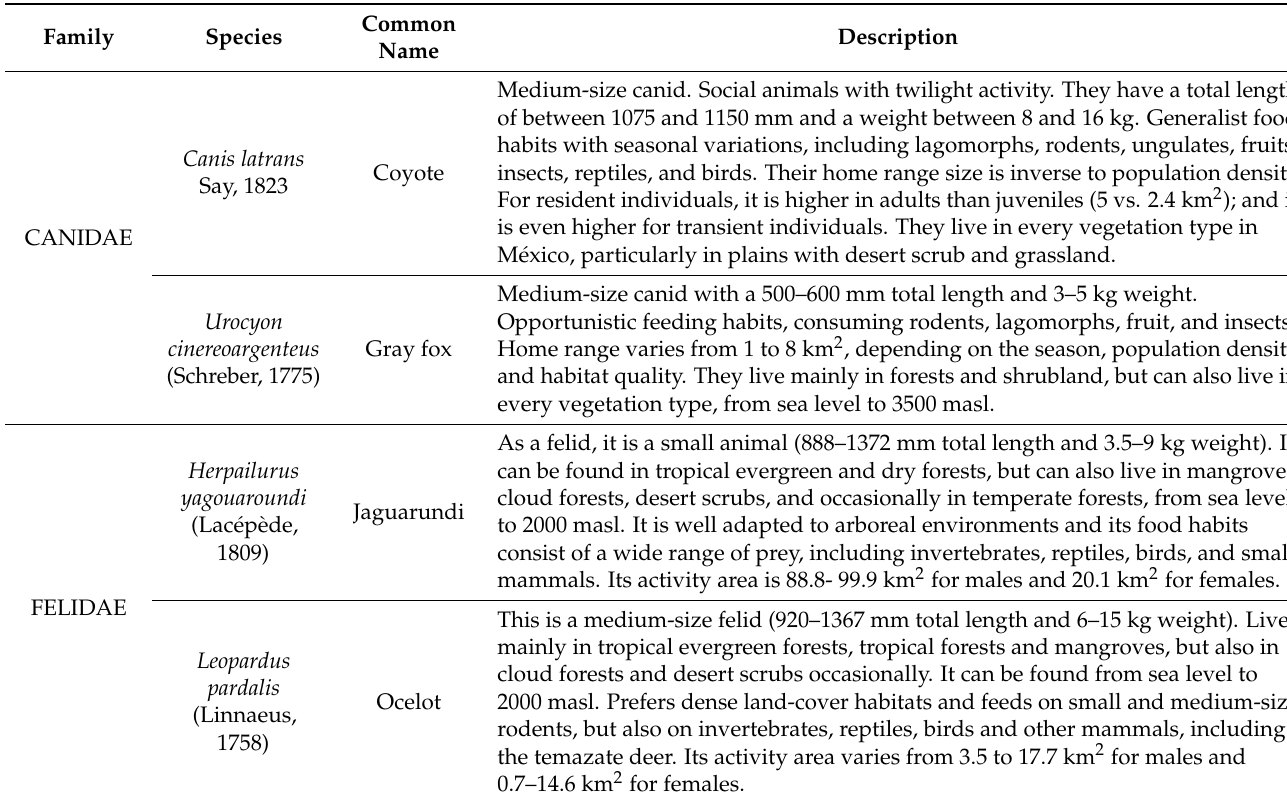
Table A2. Characteristics of study